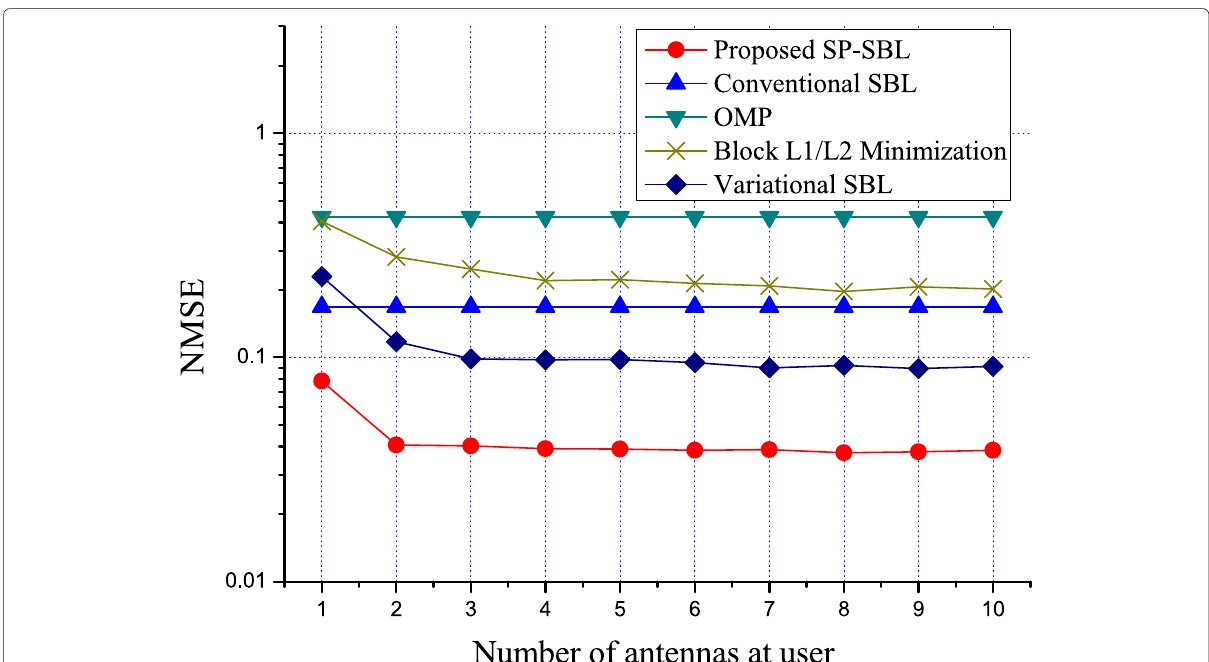
Fig. 7 NMSE performance for different numbers of antennas at users, i.e., M , where N = 64. The length of pilot sequence is T = 16. Transmit SNR of = 15 dB. The angular spread is (cid:3) BS is NP σ 2